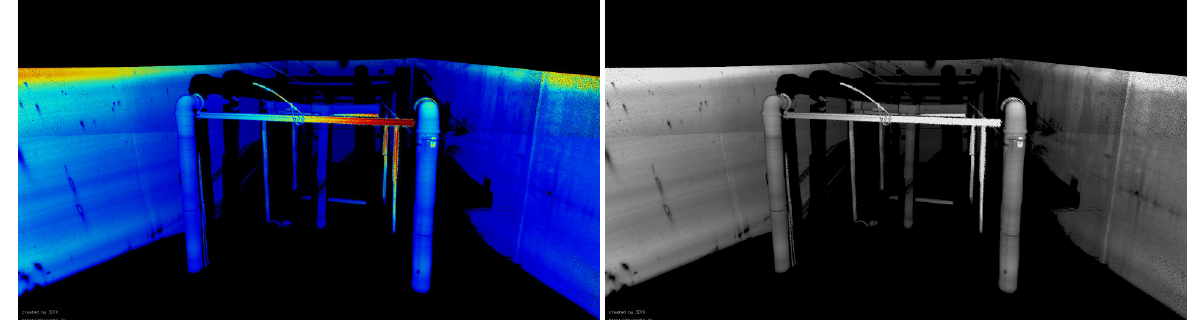
Figure 11. First underwater point cloud of the pipe test struc ture acquired with the 3D laser line